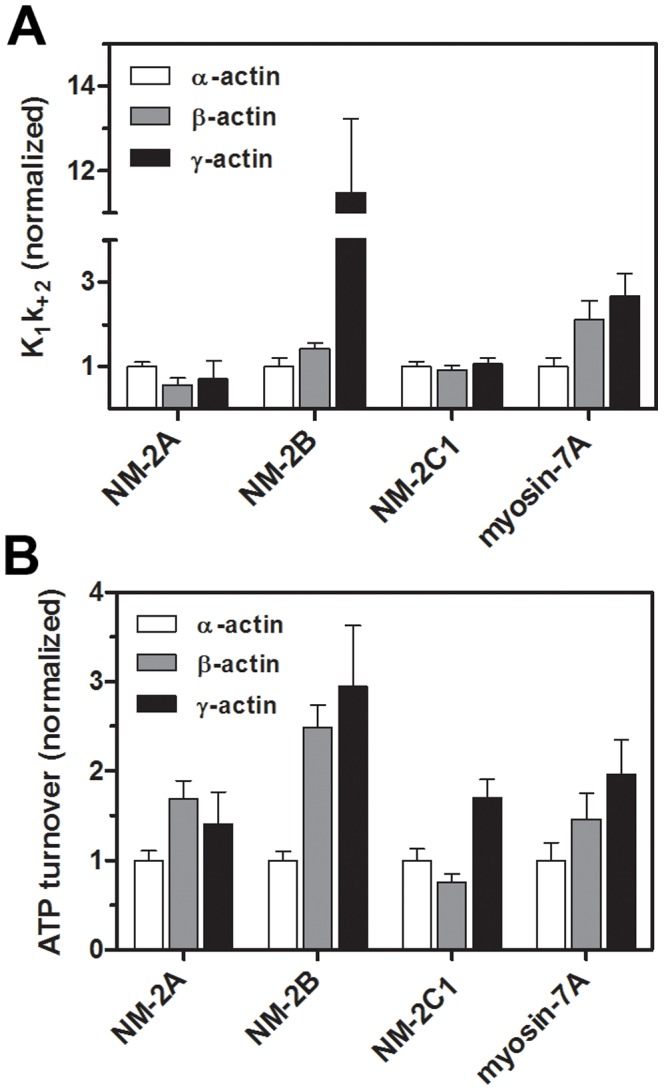
Flash photolysis experiments with nonmuscle myosin and actin isoforms.(A) The graphs show the relative changes of the apparent second order rate constants K1k+2. P-values of unpaired t-tests were <0.05 for the combinations NM-2A (α- and β-actin), NM-2B (α- and β-/γ-actin), and myosin-7A (α- and β-/γ-actin). (B) ATP turnover rates of nonmuscle myosin isoforms interacting with β- or γ-actin. P-values of unpaired t-tests were <0.05 for the combinations NM-2A (α- and β-/γ-actin), NM-2B (α- and β-/γ-actin), NM-2C1 (γ- and α-/β-actin), and myosin-7A (all combinations). Rates were normalized using α-actin as a reference. The ATP-induced dissociation is accelerated for the complexes NM-2B/β-/γ-actin and myosin-7A/β-/γ-actin. The interaction of cytoplasmic actins and NM-2 or myosin-7A isoforms leads to 2- to 3-fold increased catalytic activities. Reference values for K1k+2 (µM−1 s−1) as determined with α-actin are as follows: NM-2A, 0.14±0.003; NM-2B, 0.24±0.02; NM-2C1, 0.89±0.01; myosin-7A, 0.44±0.01 (see also [32], [48]).